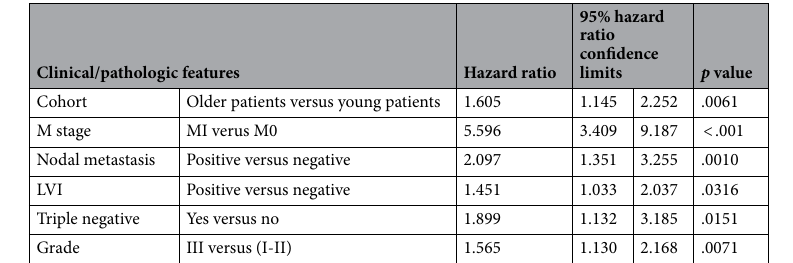
Table 2. Effect of clinical and pathologic variables on overall survival of older versus young patients. M = Metastasis; LVI = lymphovascular invasion.